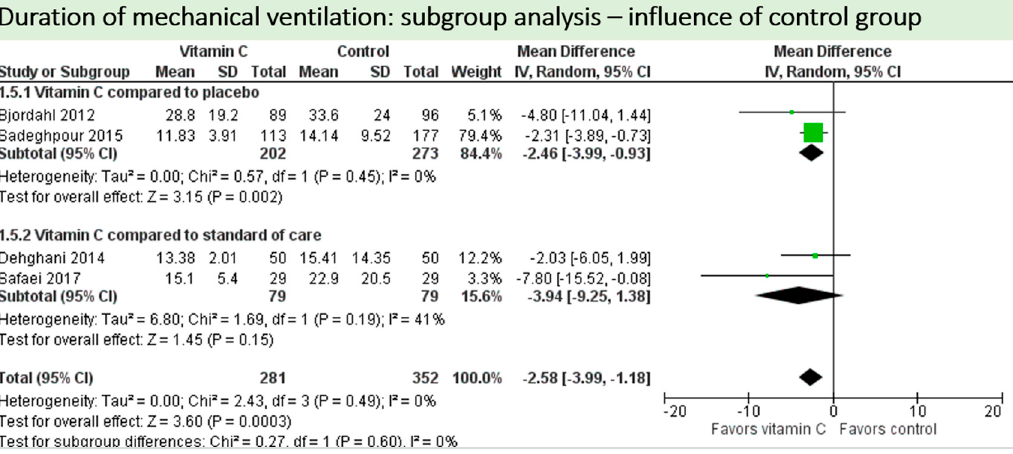
Figure 18. Duration of mechanical ventilation in hours: subgroup analysis—influence of control group.